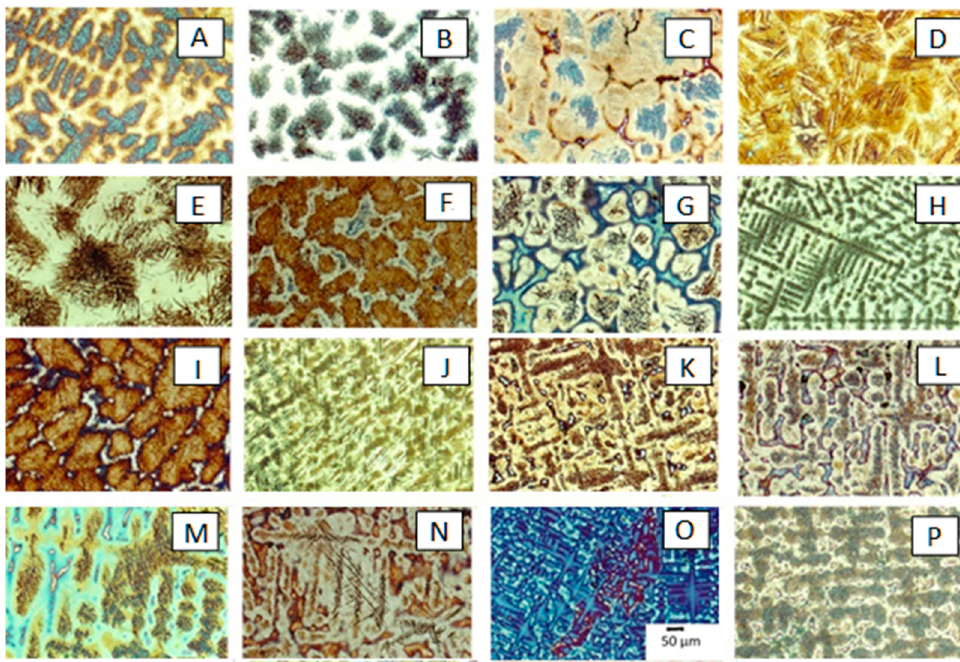
Figure 4. Examples of micrographs obtained after heat treatment: ( A ) casting 1, tempered at 150 °C; ( B ) casting 2, tempered at 550 °C; ( C ) casting 2, tempered at 850 °C; ( D ) casting 3, tempered at 100 °C; ( E ) casting 3, tempered at 200 °C; ( F ) casting 3, tempered at 800 °C; ( G ) casting 3, tempered at 850 °C; ( H ) casting 5, tempered at 250 °C; ( I ) casting 5, tempered at 800 °C; ( J ) casting 6, tempered at 100 °C; ( K ) casting 7, tempered at 850 °C; ( L ) casting 7, tempered at 900 °C; ( M ) casting 8, tempered at 250 °C; ( N ) casting 8, tempered at 750 °C; ( O ) casting 9, tempered at 800 °C; ( P ) casting 10, tempered at 900 °C.